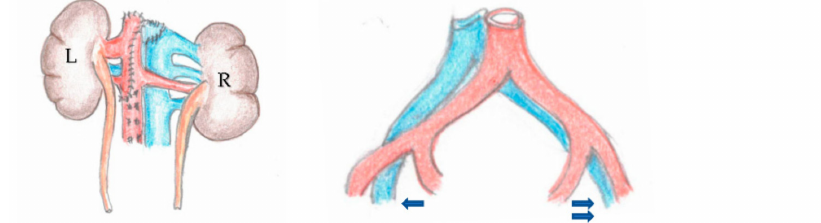
Figure 2. ( A ) The inverted reconstructed dual kidneys ready to be transplanted to the right iliac fossa showing the backwall of the aorta with the spinal arteries suture ligated. The vena is on the right side of the aorta. The left kidney is figured with the aortic cap bearing the 2 renal arteries and a cava patch carrying the left renal vein hidden by the artery. The kidneys represented herein would require 3 separate arterial anastomoses and 5 venous anastomoses had the aorta and the vena cava not been used as a single arterial inflow and venous inflow, respectively. ( B ) The pelvic vascular anatomy is shown. Taking consideration of Figure 2A, one can note the concordance of the donor vena cava with the recipient’s right iliac vein, facilitating the venous anastomosis (single arrow) and avoiding the arterio–venous scissoring leading to renal vein thrombosis. Taking consideration of Figure 1B when the left iliac quadrant is used, the anatomic inversion of the en bloc kidneys is not required, since there is already anatomic concordance of the donor vena cava and the left iliac vein. The double arrow shows the site of the left iliac